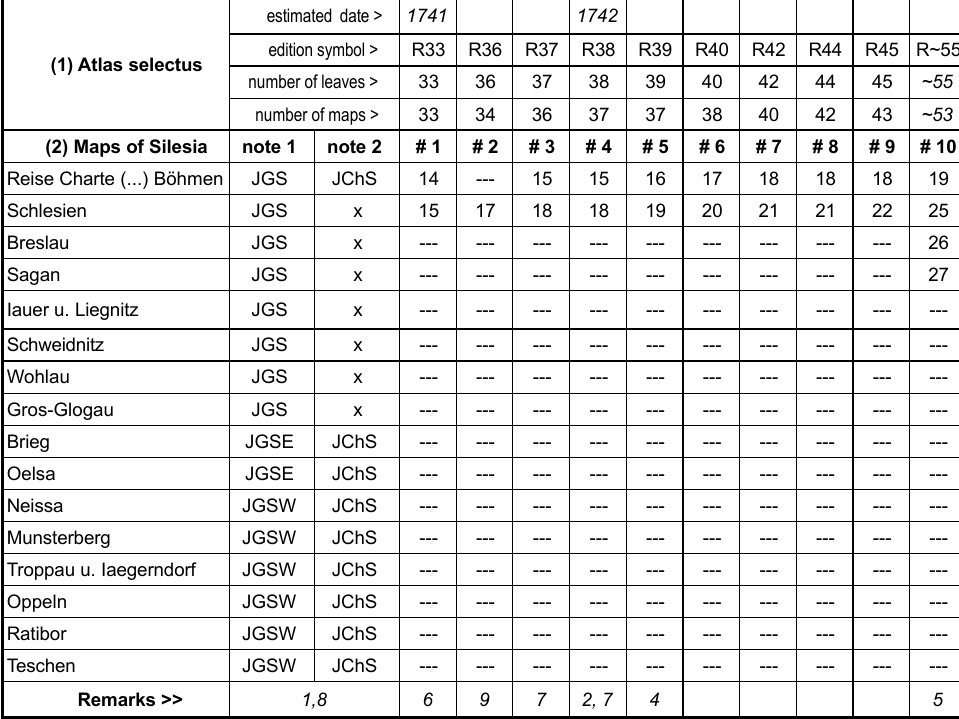
Table 1. Atlas selectus : (1) Editions, dating, number of leaves / maps. (2) Maps of Silesia: location in the atlas and chronology of appearance